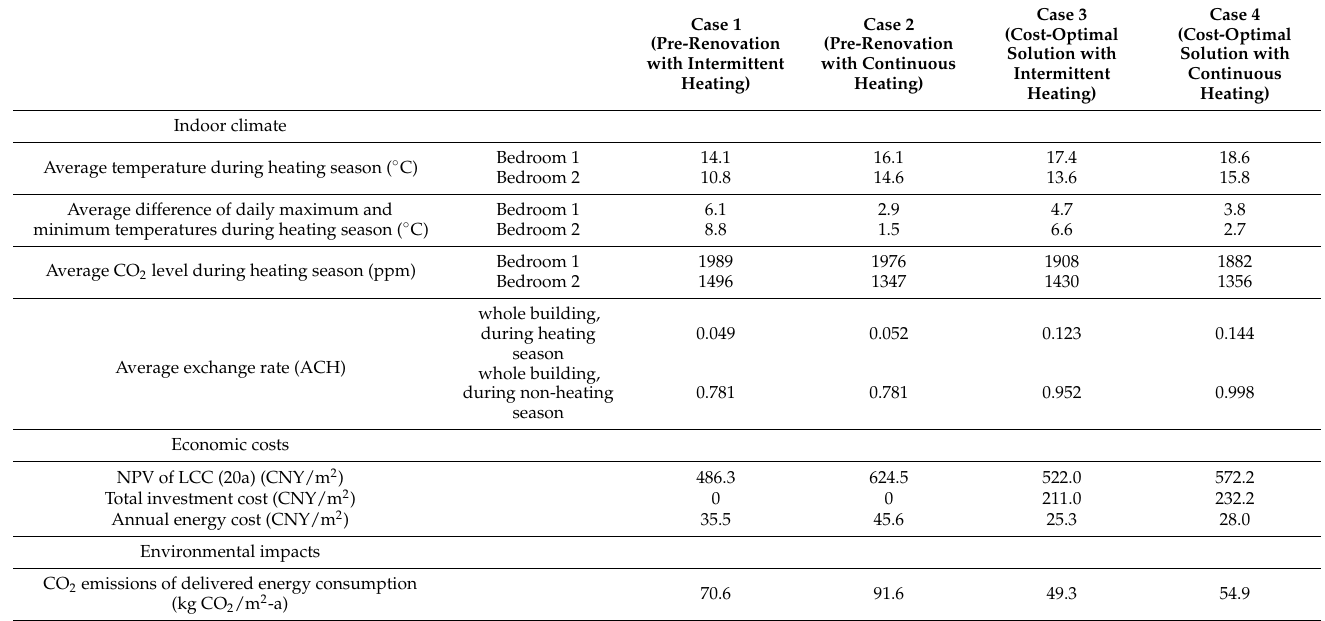
Table 7. Case-based evaluation of envelope renovation and heating